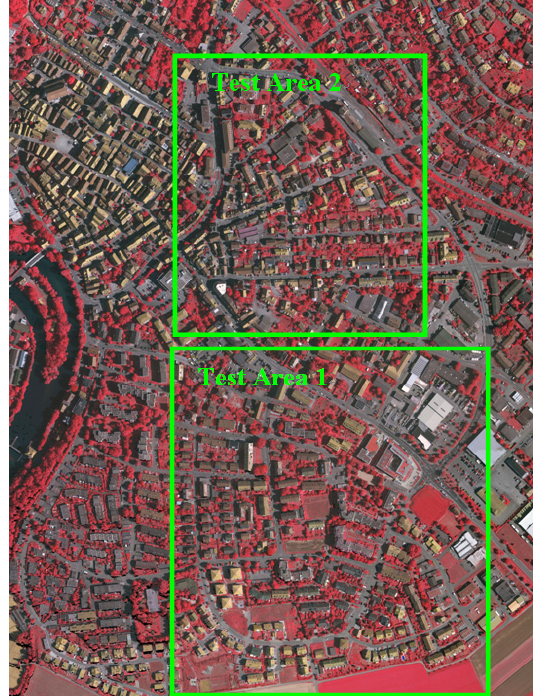
Figure 4: The true ortho-photo of the test